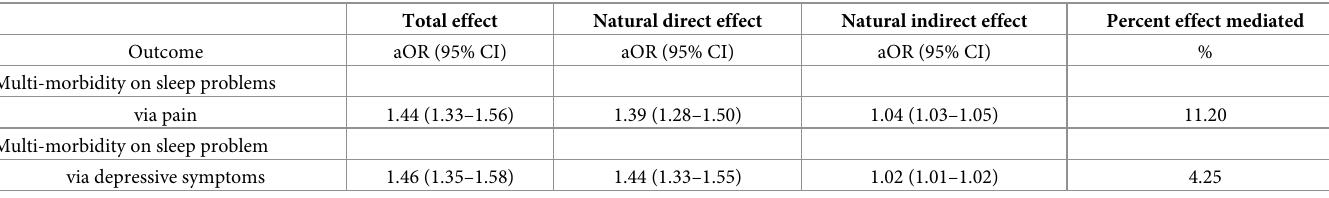
Table 3. Direct and indirect effects of multi-morbidity on sleep problems through pain and depressive symptoms (n =